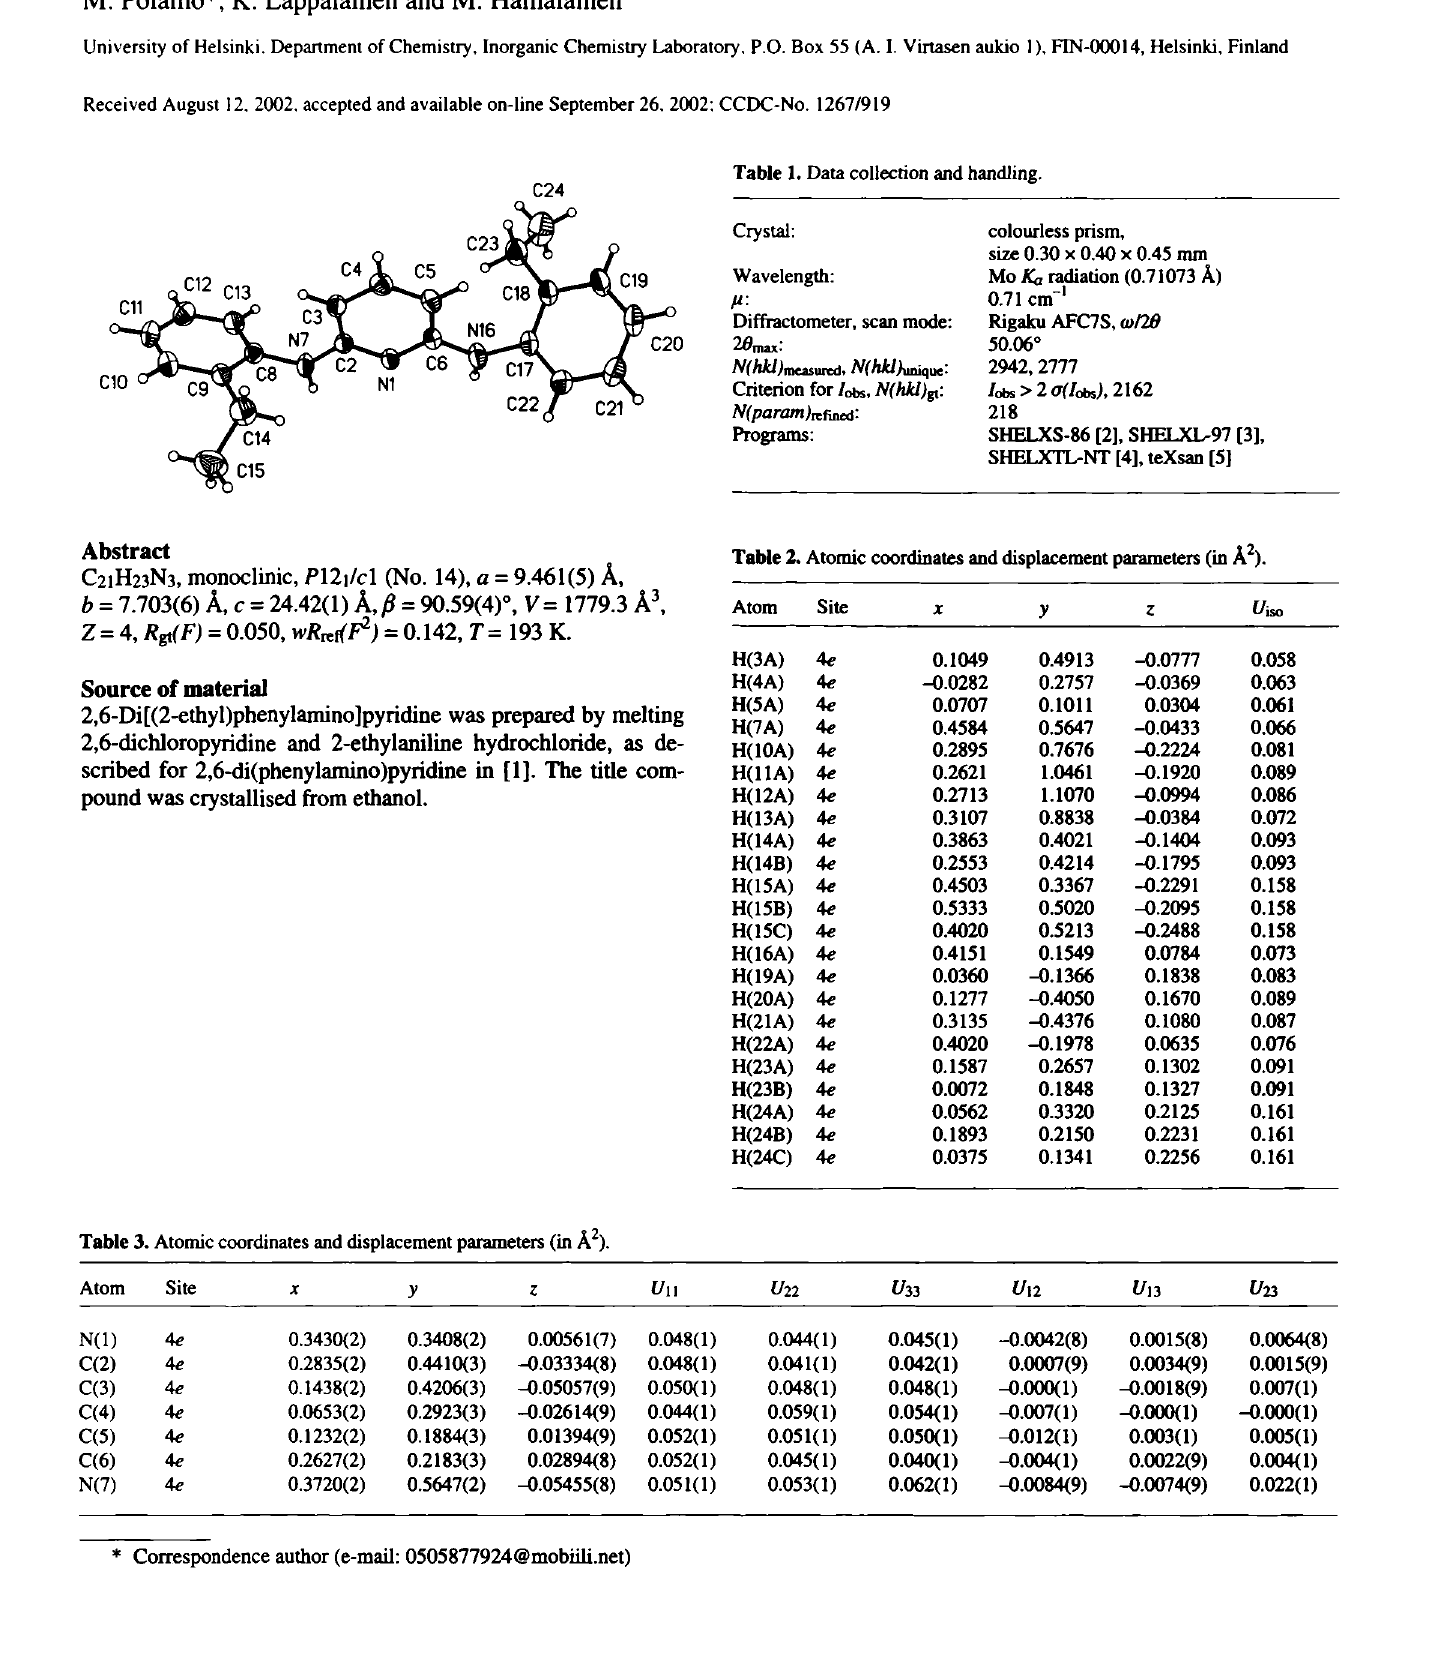
Table 1. Data collection and handling.